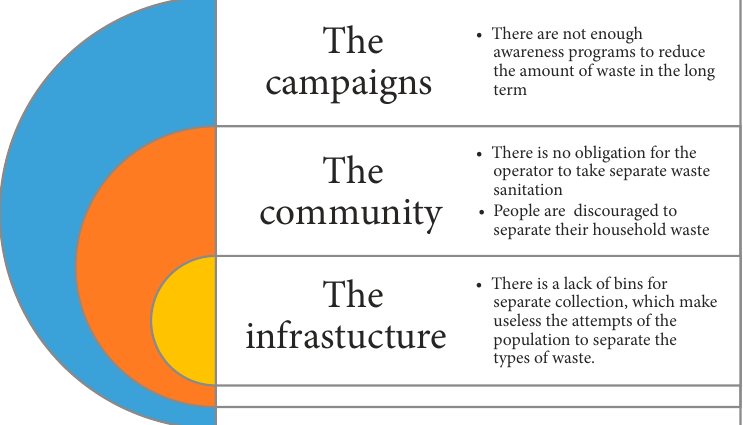
Figure 7. The public support in the field of waste